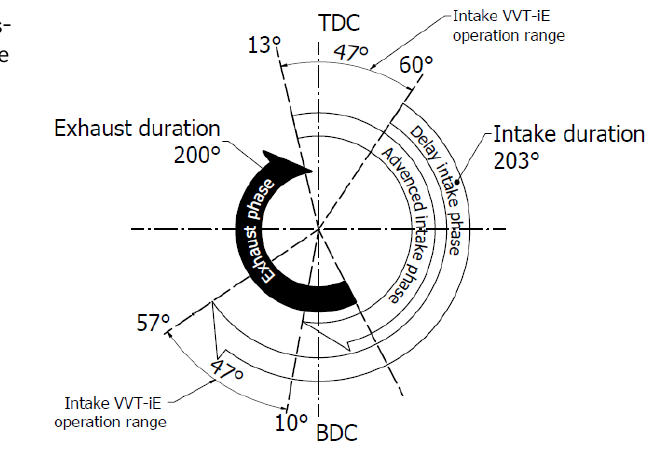
Fig. 18. Valve timing diagram after cylinder head